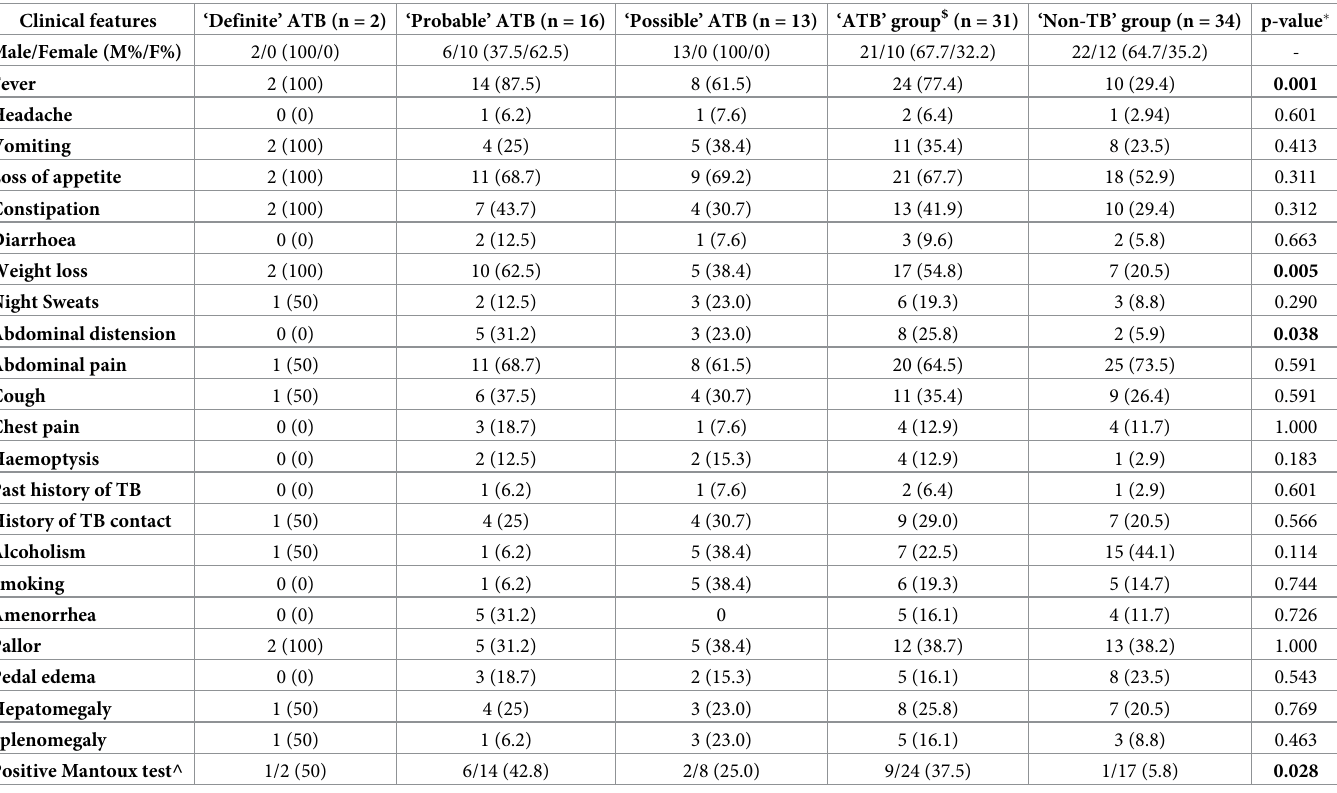
Table 1. Characteristics and clinical features of the study participants #